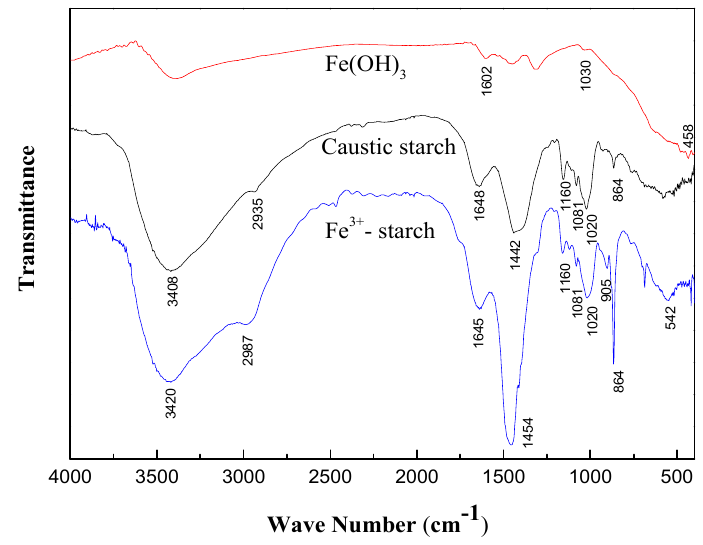
Figure 2. FTIR spectra of Fe 3+ -starch.